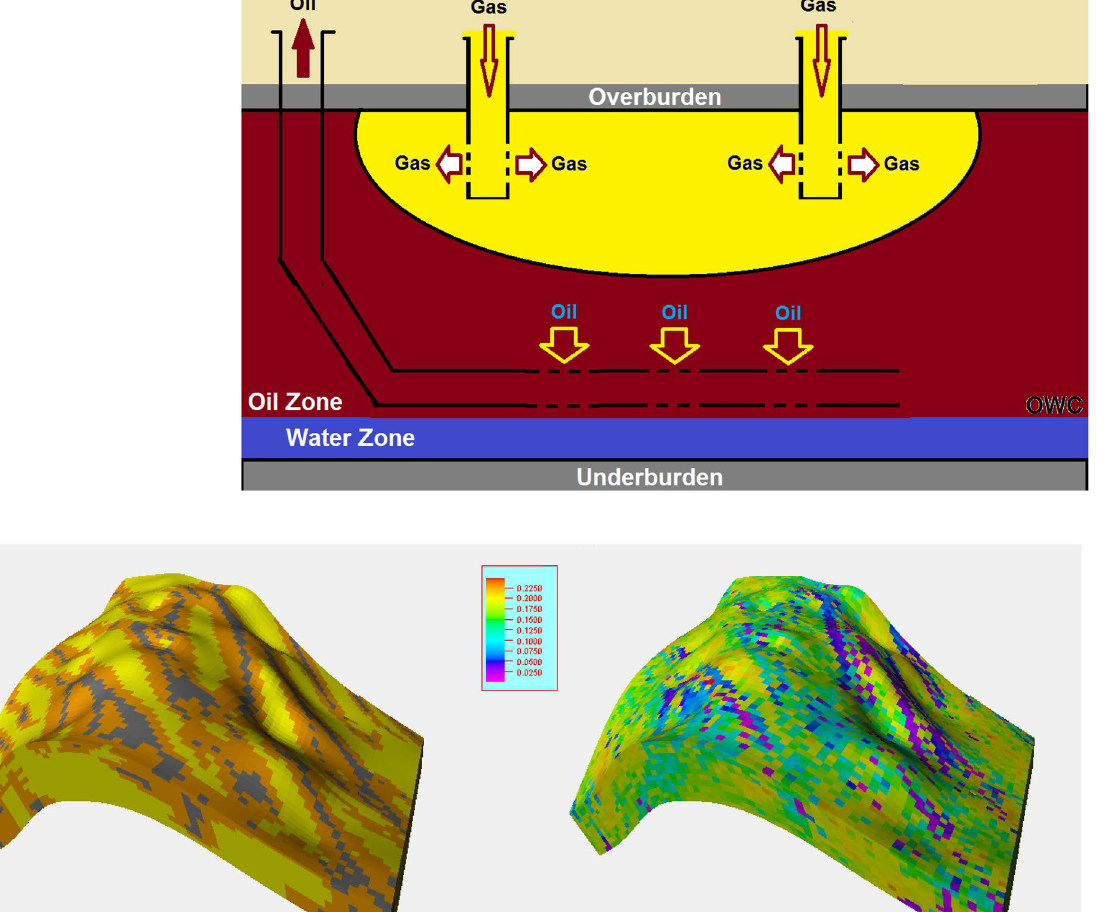
Fig. 2 Schematic of GAGD